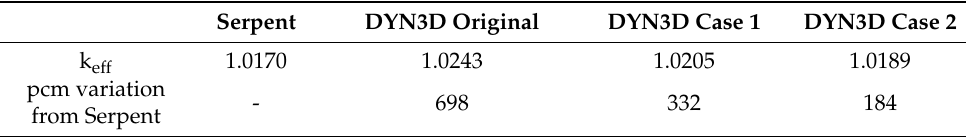
Table 5. K eff of the three different assembly models.